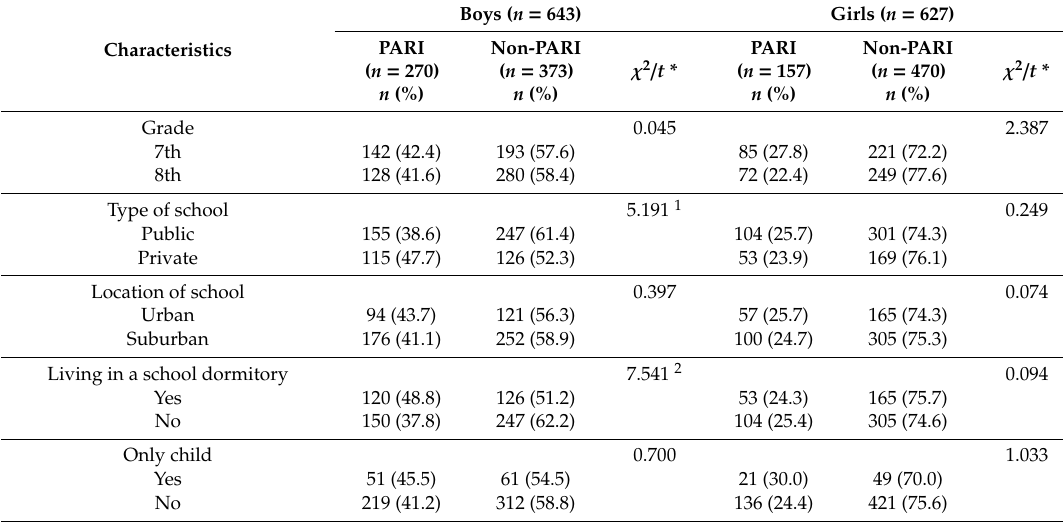
Table 1. Comparison of socio-demographics in physical activity-related injuries (PARI) and non-PARI groups among di ff erent